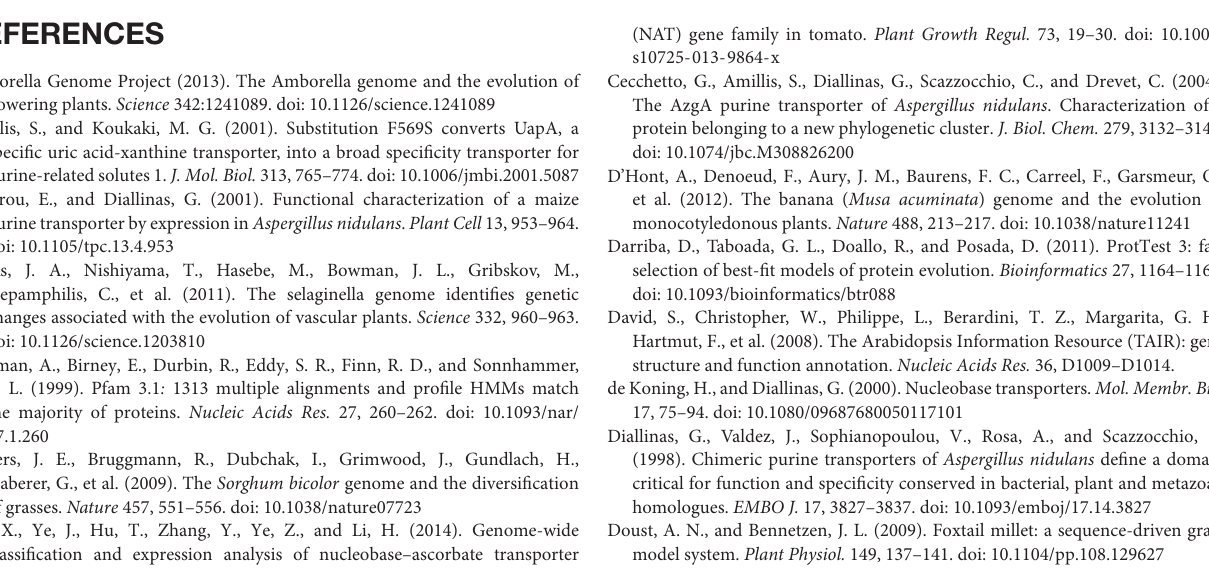
FIGURE S1 | Correlation between the number of NCS2 genes and the total number of genes in a genome. FIGURE S2 | Analysis of NCS2 genes from 20 species based on phylogenetic trees constructed using the maximum-likelihood and Bayesian methods. (A) Maximum-likelihood tree; (B) Bayesian tree. FIGURE S3 | Sliding-window plots of representative duplicated NCS2 genes in maize. The window and step sizes are 150 and 9 bp, respectively. Nucleotide positions and Ka/Ks ratios are indicated on the x -axis and y -axis, respectively.